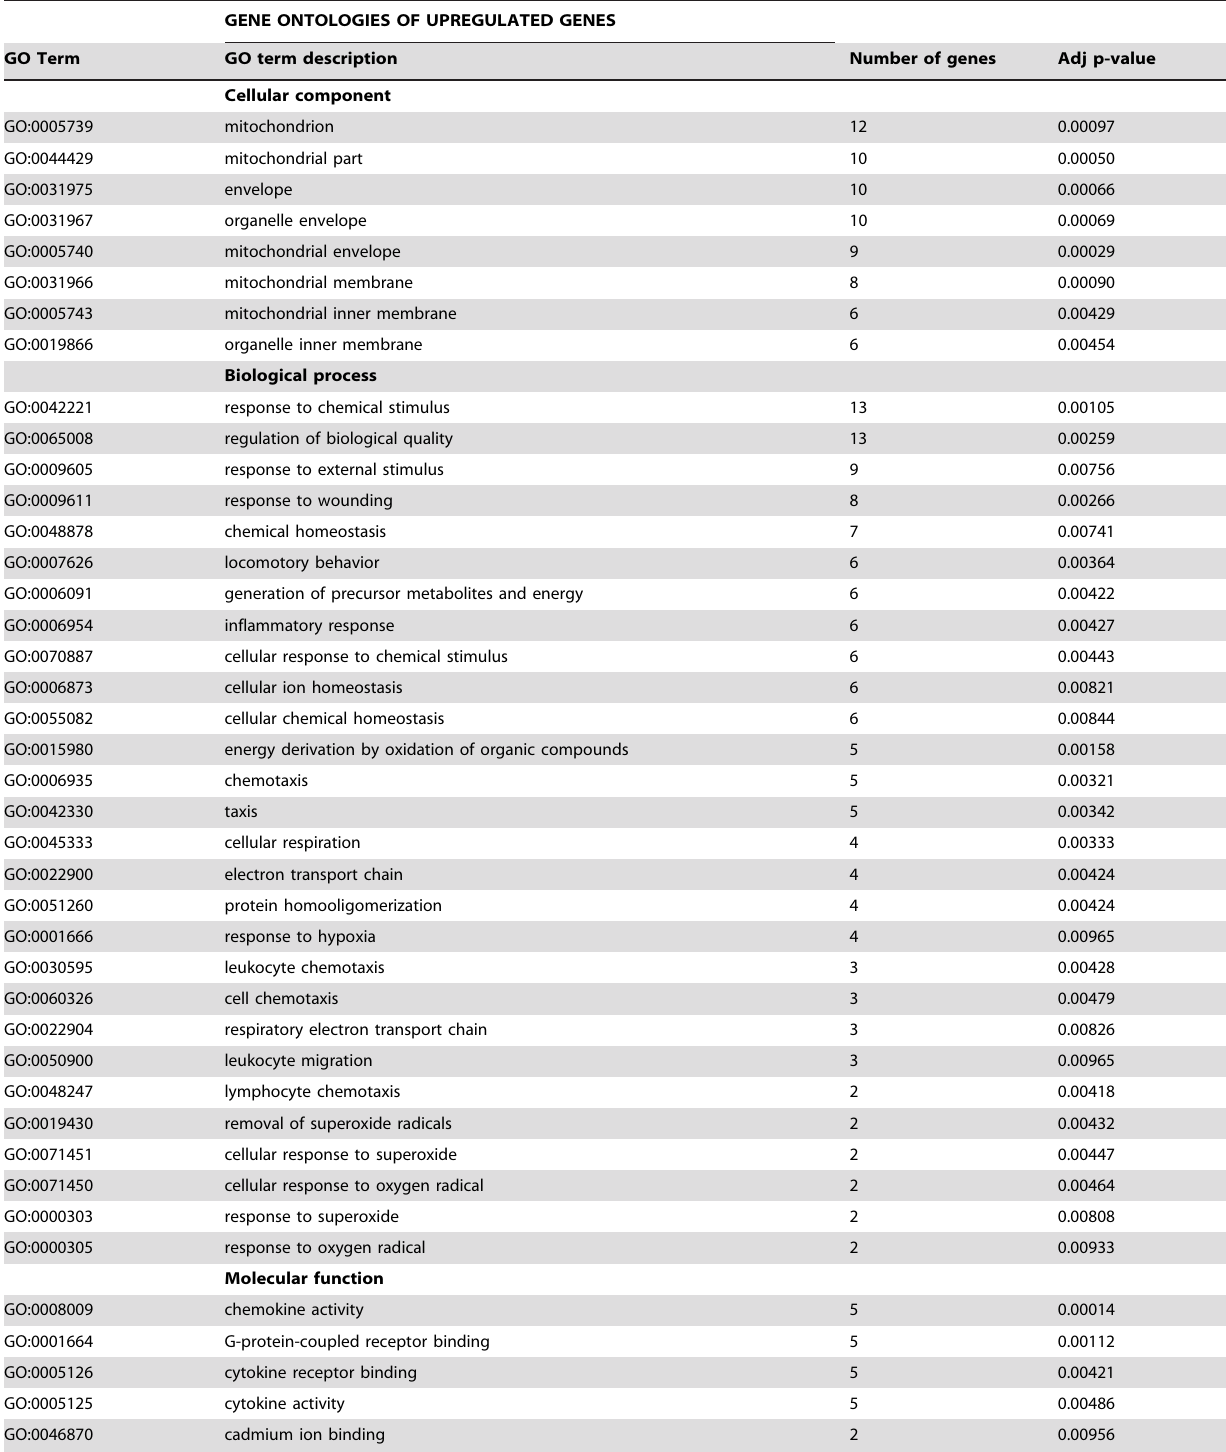
GENE ONTOLOGIES OF UPREGULATED